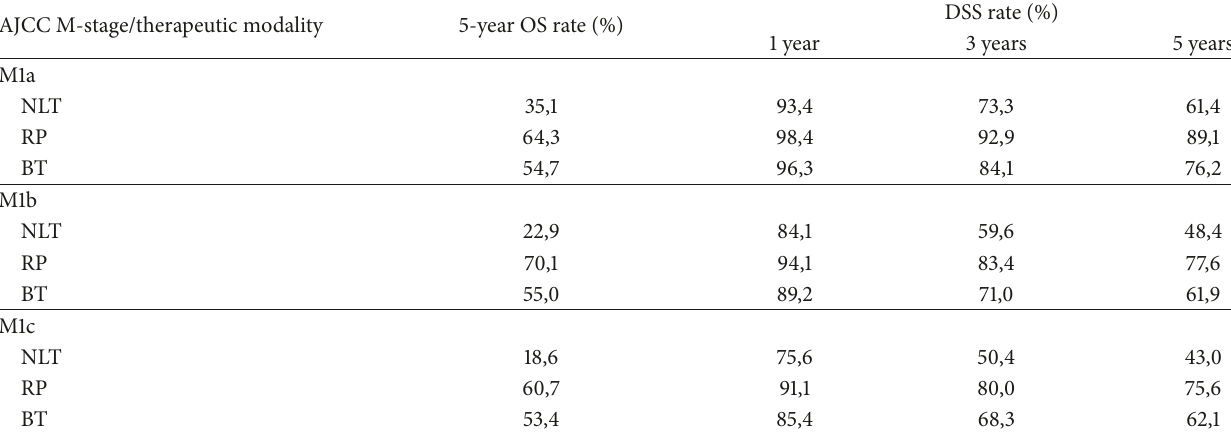
Table 5: Overall survival and disease-specific survival by stage M according to the AJCC criteria and therapeutic modality, adapted from Culp et al. (2014) [13].